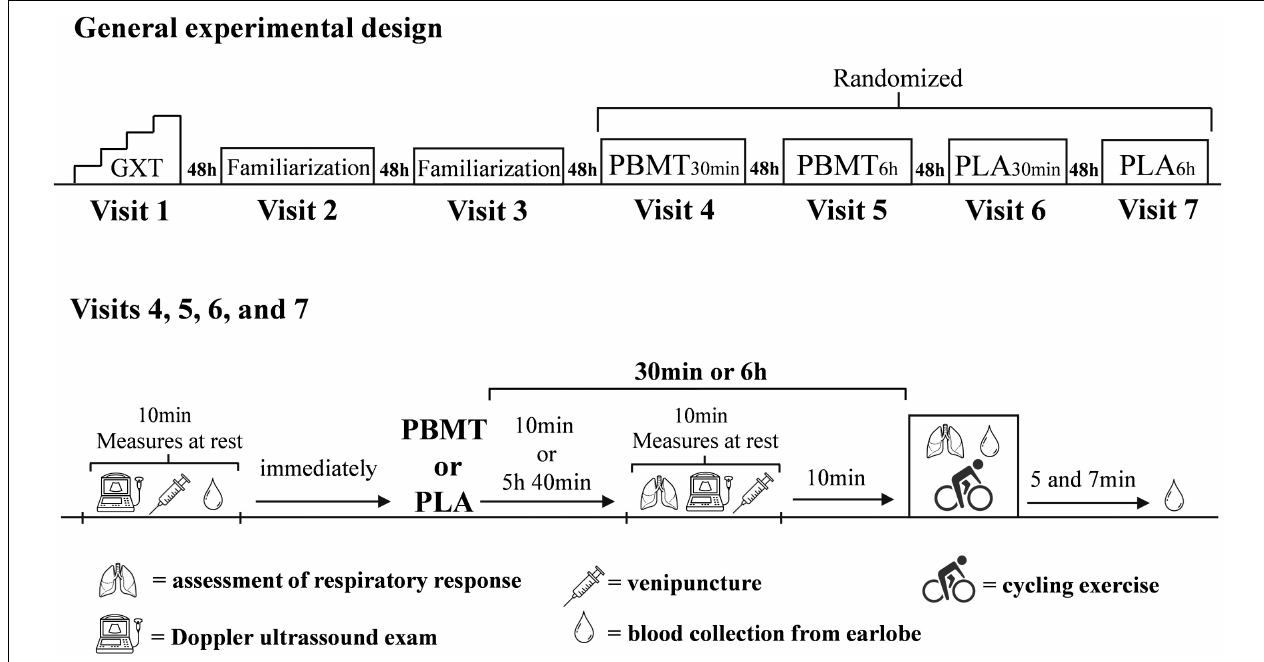
FIGURE 1 | General experimental design of the study. GXT, graded exercise test until exhaustion; PBMT, photobiomodulation therapy; PLA,